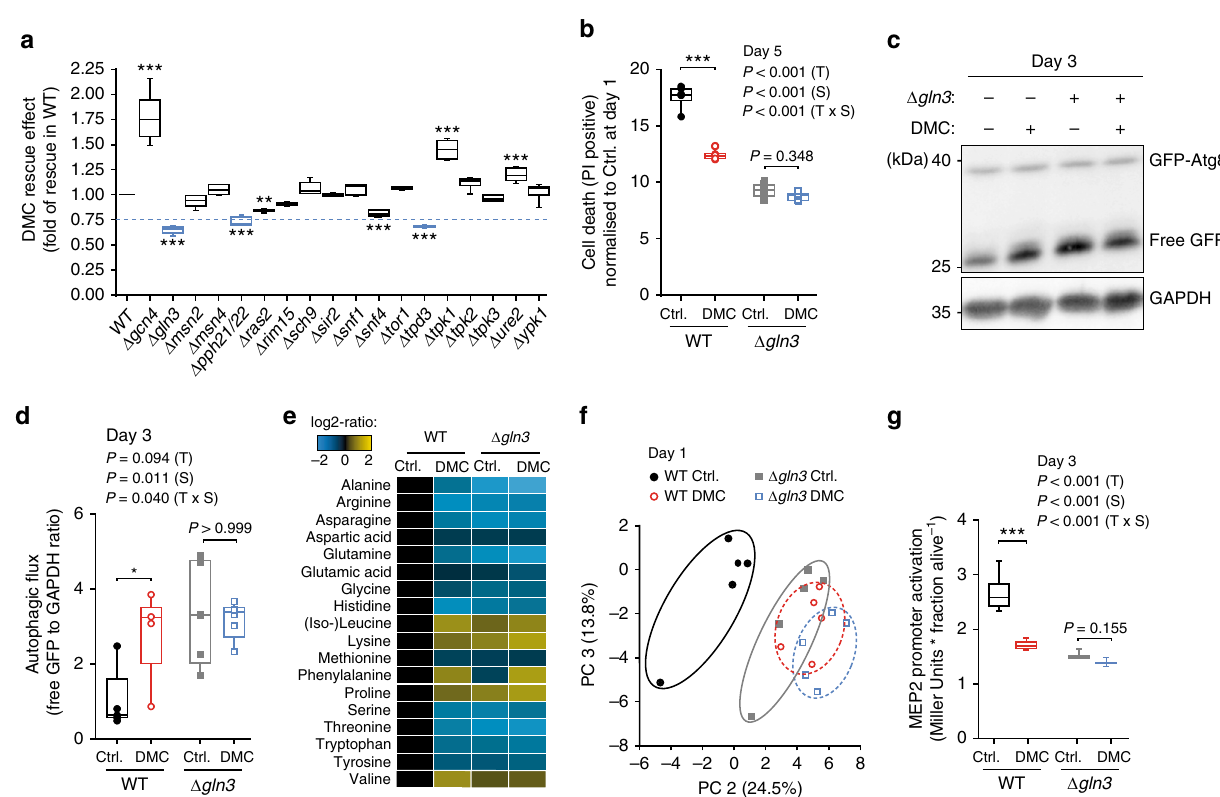
Fig. 5 Gln3 is a functional target of 4,4 ’ -dimethoxychalcone. a DMC-rescuing effect determined as the AUC of PI-positive cells (day 1 – 5) upon DMC treatment (100 µ M) of yeast deletion mutants involved in autophagic signalling, normalised to the rescuing effect in wildtype (WT) cells. Hits below the threshold (0.75) are depicted in blue. Comparisons by ANOVA/Bonferroni. ** P < 0.01, *** P < 0.001, n = 6 independent biological replicates. b Cell death at day 3 of chronological ageing of DMC-treated (100 µ M) yeast wildtype (WT) and GLN3 -de fi cient mutant strains determined by PI staining normalised to Ctrl. at day 1 ( b ), *** P < 0.001, n = 6 independent biological replicates. ( c , d ) Autophagy induction of DMC-treated (100 µ M) yeast wildtype (WT) and GLN3 -de fi cient mutant strains indicated by the free GFP to GAPDH ratio normalised to WT Ctrl. ( d ), * P = 0.0242, n = 5 independent biological replicates; representative immunoblot in ( c ). e , f Changes in intracellular amino acid concentrations ( e ) and principal component analysis of yeast metabolites ( f ) 24 h after DMC-treatment (100 µ M) in wildtype (WT) and GLN3 -de fi cient yeast cells. g Gln3-dependent MEP2 expression using a P MEP2 -LacZ reporter at day 3 after DMC-treatment (100 µ M) in wildtype (WT) and GLN3 -de fi cient yeast cells. ** P = 0.0056, n = 12 (WT) n = 9 ( Δ gln3 ) independent biological replicates; Comparisons in ( b , d , g ) by two-way ANOVA (T, treatment; S, strain; T × S, interaction) followed by Bonferroni-corrected simple main effects. Box plots represent IQR (line at median) and whiskers 10 – 90 percentile. Source data for ( a , b , d – g ) are provided as a Source Data fi